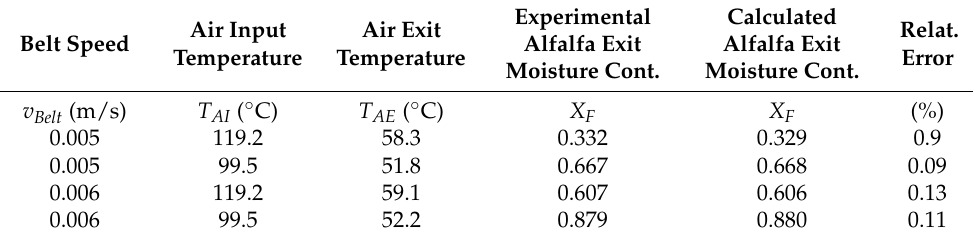
Table 5. Alfalfa experimental moisture content values at the exit dryer vs. calculated ones by Equation